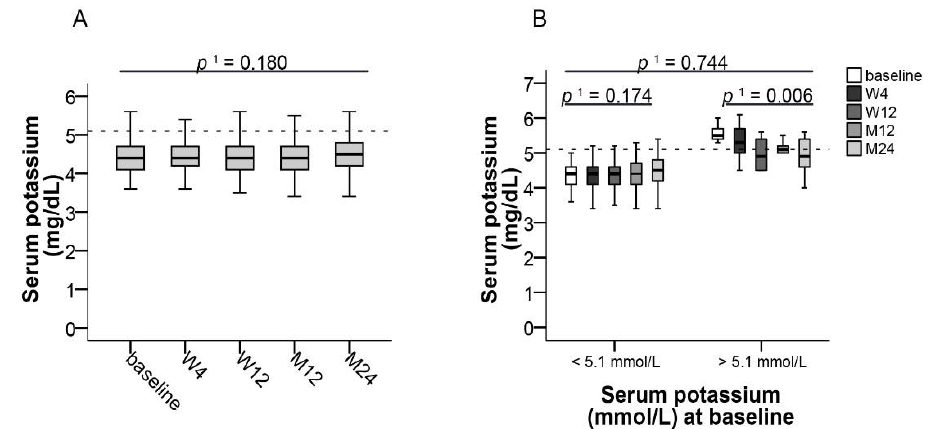
Figure 6. Potassium levels after switching LCPT. Boxplots show median values with 95% CI for ( A ) potassium levels and ( B ) for potassium according to normal or increased values at baseline, both at the baseline visit as well as at weeks 4 and 12 and at months 12 and 24. 1 with Greenhouse–Geisser correction; LCPT: once-daily MeltDose ® prolonged-release tacrolimus, M: month, W: week.